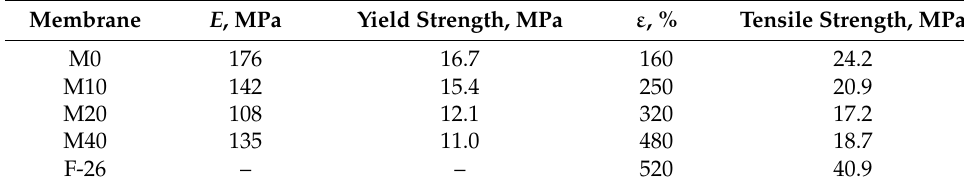
Figure 7. Engineering stress–strain curves of the membranes: M0–M40. Table 4. Dynamometric characteristics of the membranes.